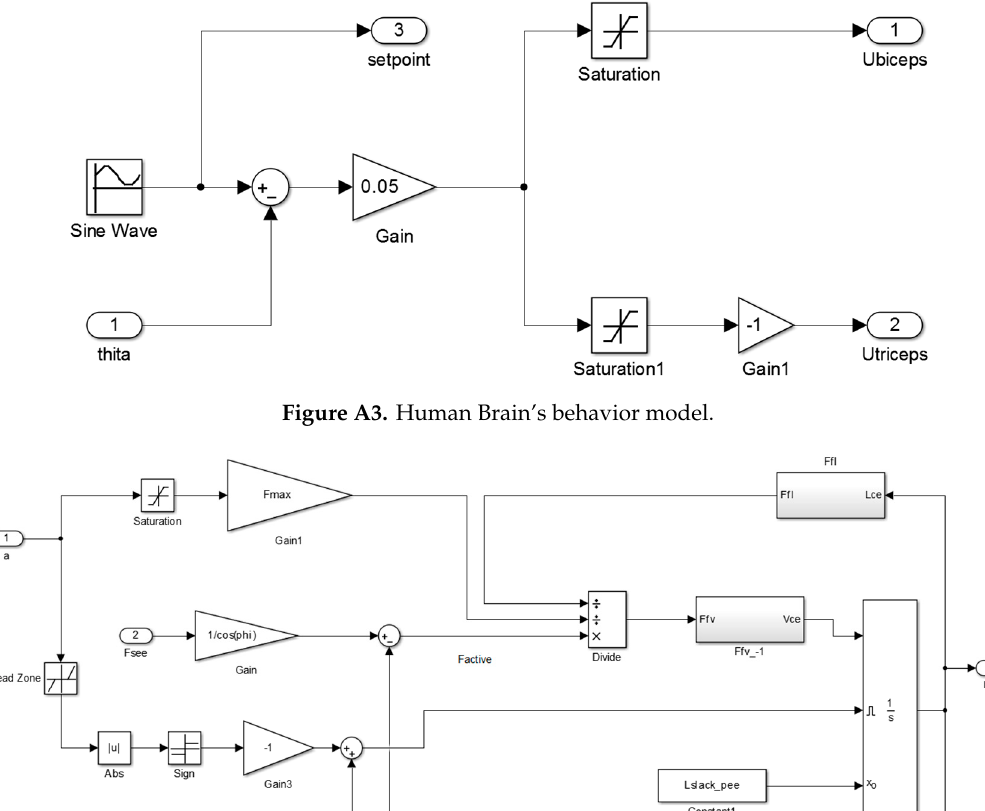
Figure A.2. Implementation of Thelen Model